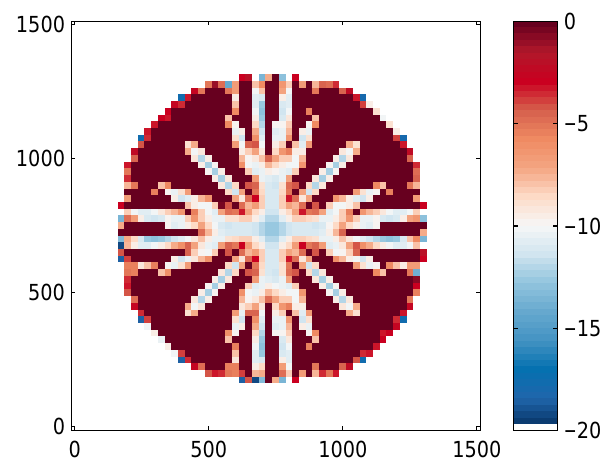
Figure B1. Predicted basal temperatures (corrected for pressure- dependence) according to EISMINT-II experiment